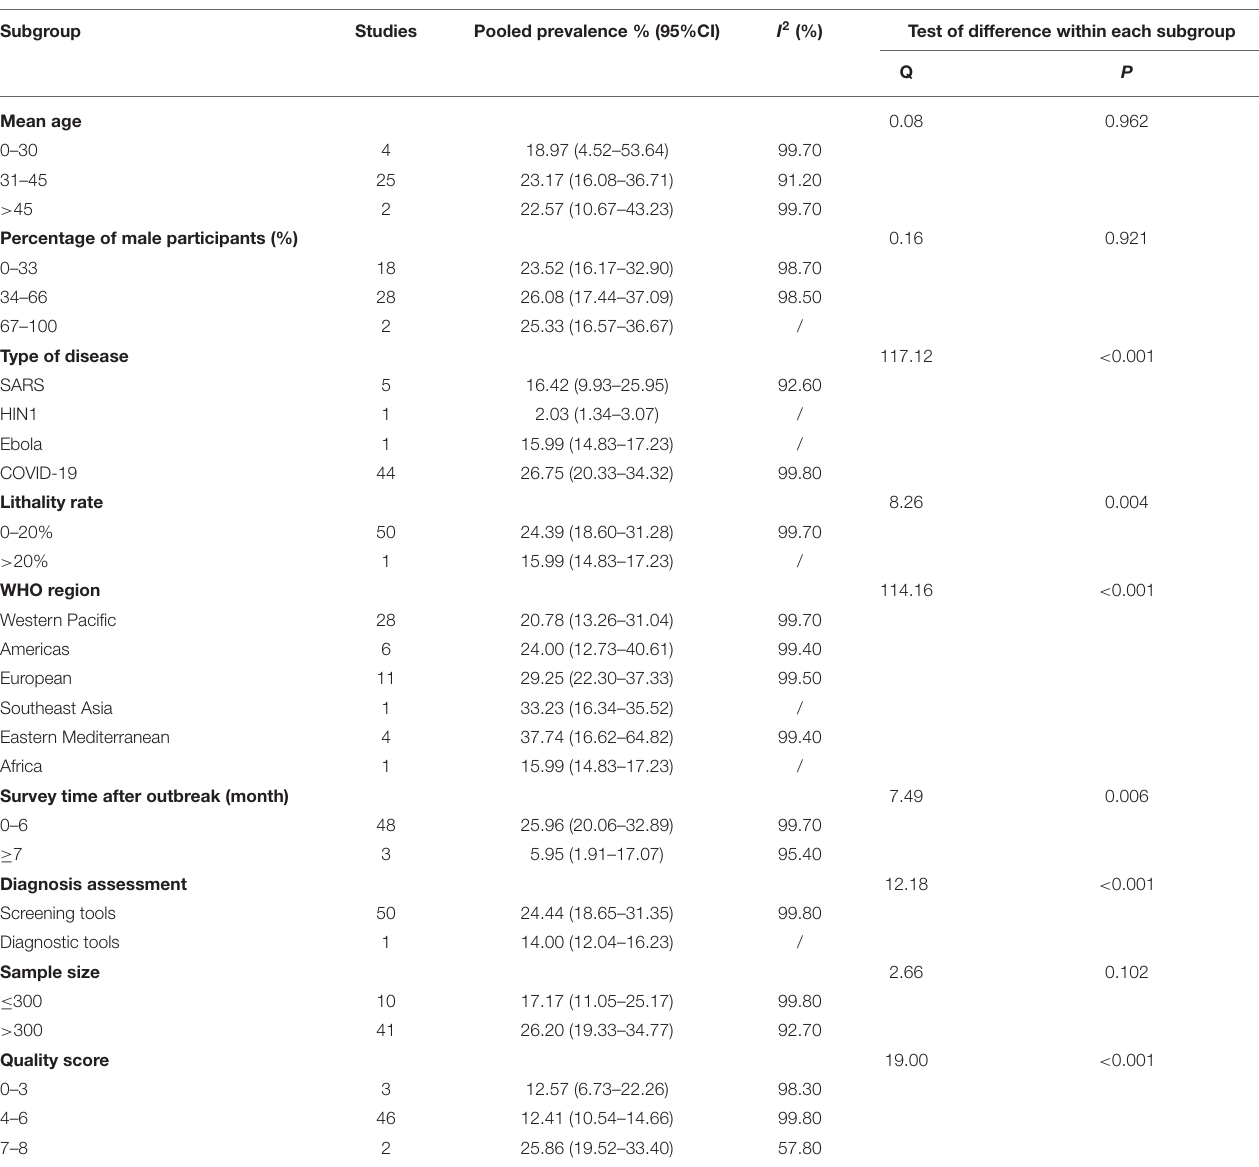
TABLE 2 | Subgroup analysis for the general